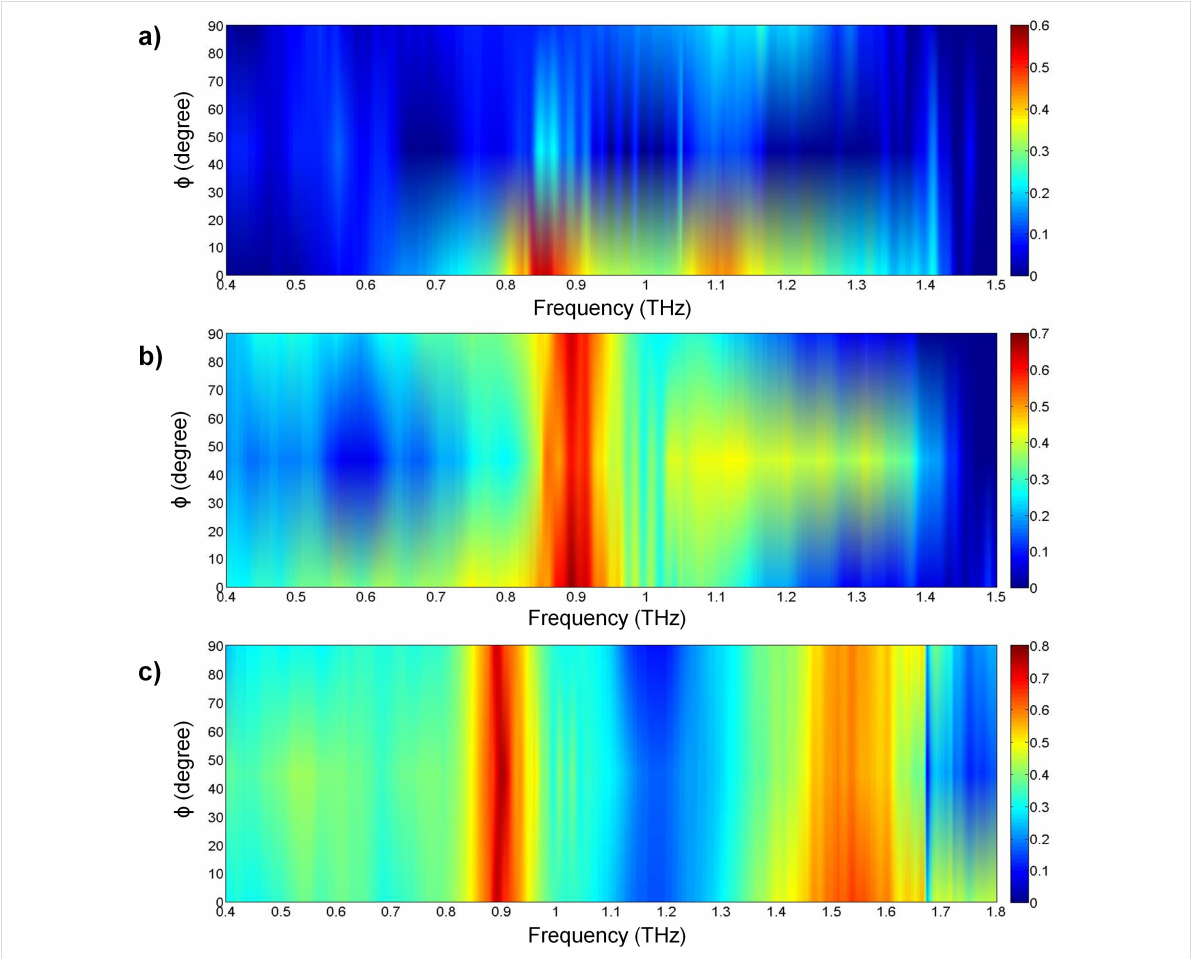
Figure 9: Measured absorbance results for polarization angles from 0° to 90° for: a) Cut-wire sandwich structure, b) cross-shaped sandwich structure, and c) star-shaped sandwich structure.